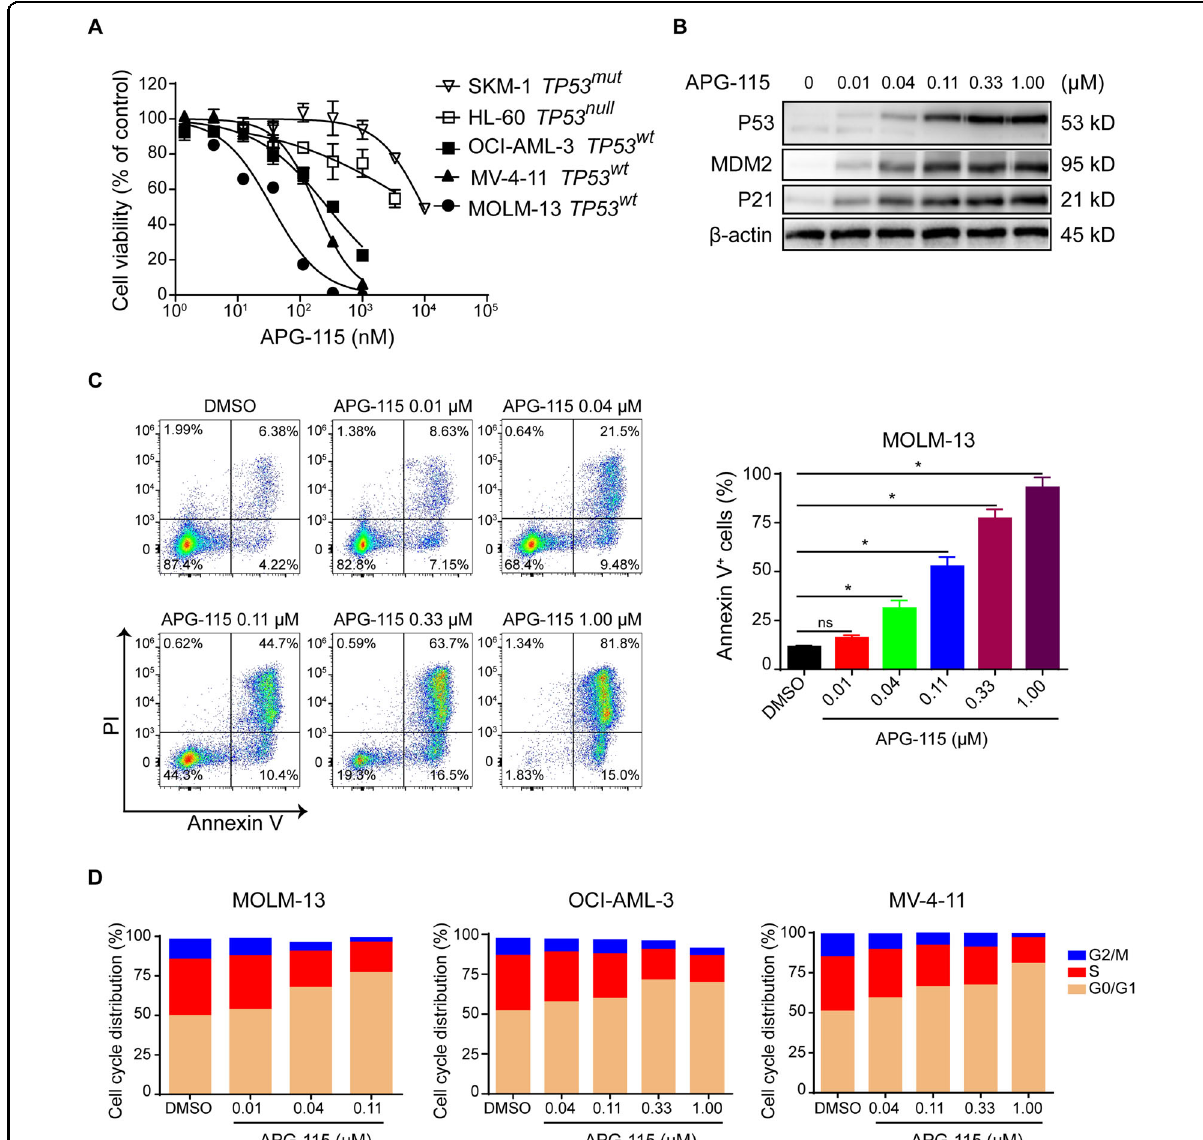
(SD) cellular viability of MOLM-13 ( TP53 wt ), MV-4-11 ( TP53 wt ), OCI-AML-3 ( TP53 wt ), HL-60 ( TP53 null ), and SKM-1 ( TP53 mut ) cells treated with increasing concentrations of APG-115 for 72 h ( n = 3 replicates). B Total protein levels of MDM2, P53, P21, and the loading control β -actin by Western blot in MOLM-13 cells exposed to APG-115 at increasing concentrations for 4 h. C Representative fl ow cytometry results from two independent experiments ( left panel ) and mean (SD) percentage of MOLM-13 cells in apoptosis ( right panel ) presented as n = 4 technical replicates. * p < 0.0001; ns not signi fi cant; compared to dimethyl sulfoxide vehicle (DMSO) via two-tailed Student t tests for data from three independently repeated experiments. D Increased cell cycle arrest in the G 0 /G 1 phase, as indicated by fl ow cytometry in AML cells exposed to increasing concentrations of APG-115 for 48 h. Data shown are representative images of two independent